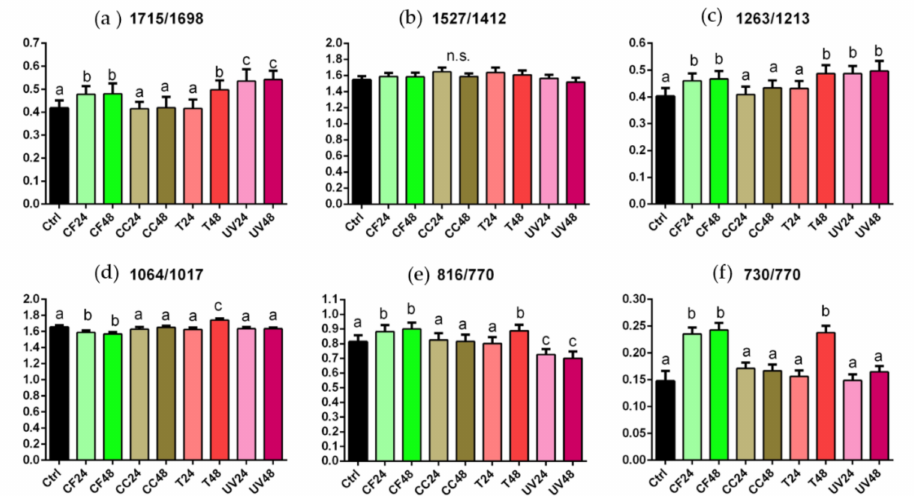
Figure 5. Statistical analysis of the following band height ratios calculated for Ctrl, CF24, CF48, CC24, CC48, T24, T48, UV24, and UV48: 1715/1698 ( a ), 1527/1412 ( b ), 1263/1213 ( c ), 1064/1017 ( d ), 816/770 ( e ) and 730/770 ( f ). Different letters indicate statistically significant differences among groups ( p < 0.05; one-way ANOVA and Tukey’s multiple comparison